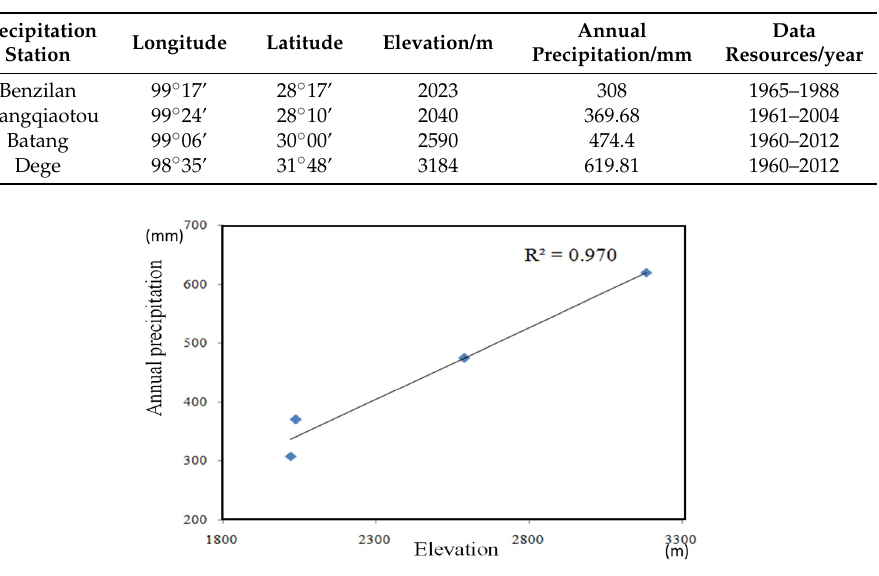
Figure 7. The relationship between elevation and annual precipitation based on the four meteorological stations.